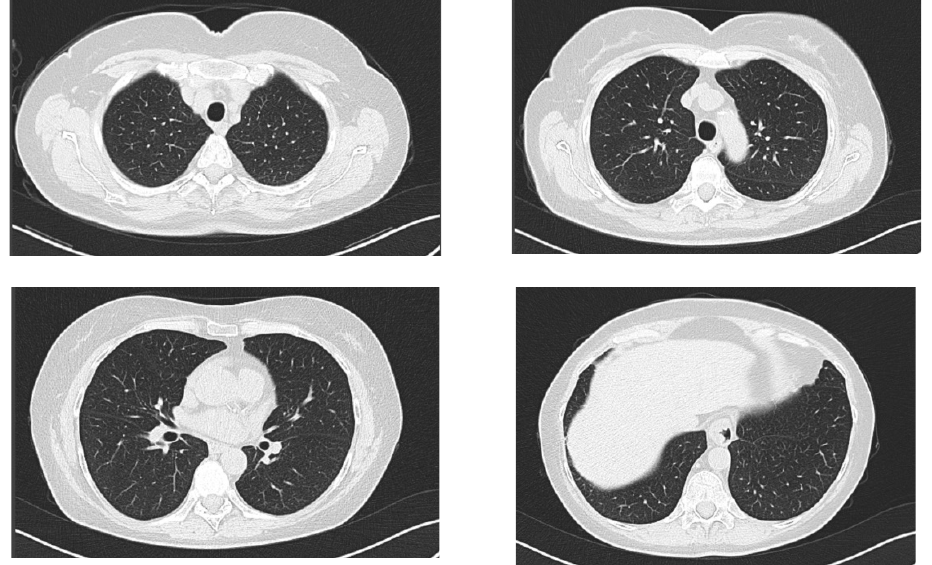
Figure 3. Axial computed chest CT of the second patient, lung window at the following levels: supraaortic trunks, aortic arch, pulmonary hila and base of the lungs, without any evidence of acute pulmonary lesions.